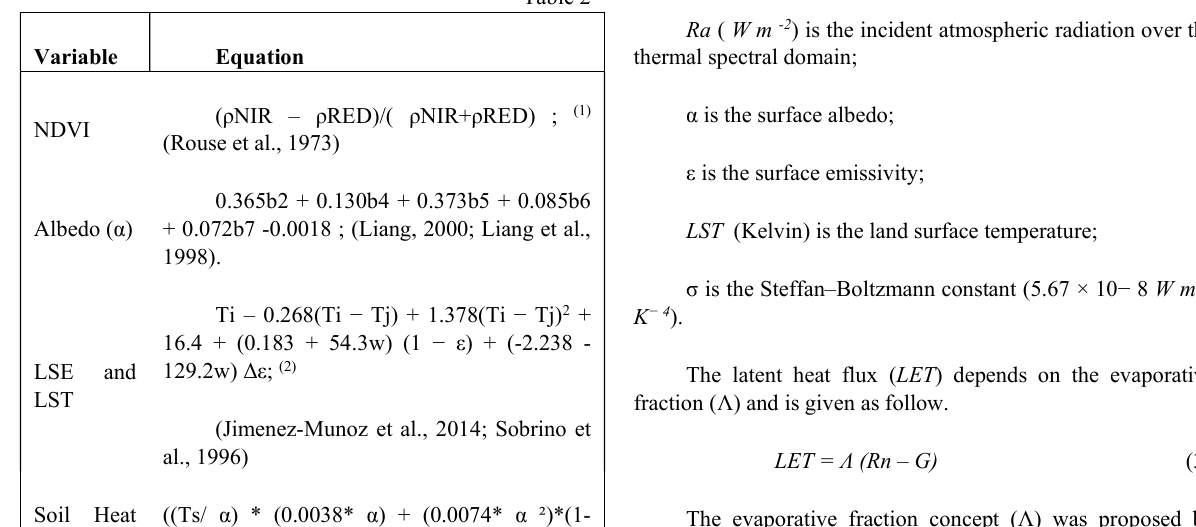
shows the algorithms used to calculate Normalized Difference Vegetation Index (NDVI), Albedo (α), Soil Heat Flux (G), Land Surface Temperature (LST) and Land Surface Emissivity (LSE). Those indices have been used to estimate the balance energy by remote sensing.